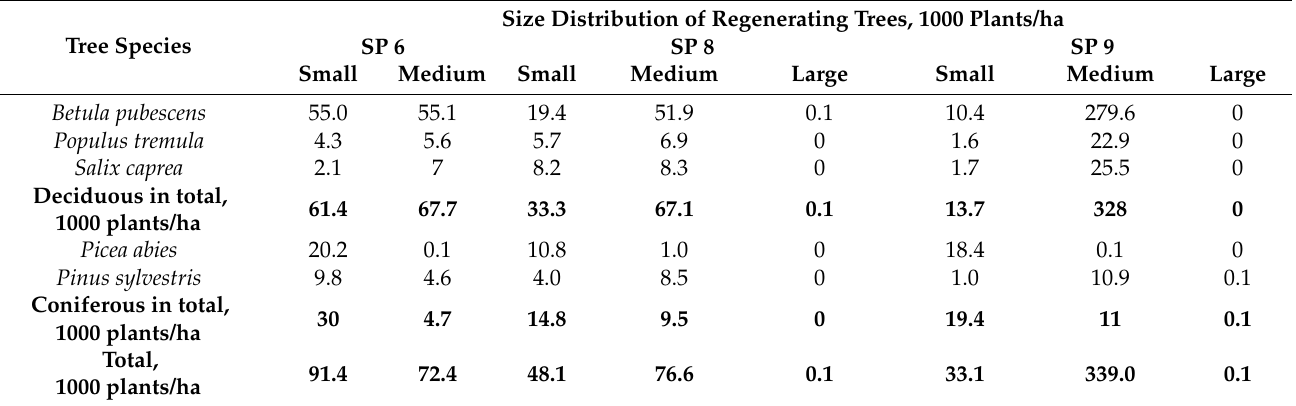
Table 3. Size distribution of the most common species of woody regeneration 10 years after surface fire. Size Distribution of Regenerating Trees, 1000 Plants/ha Tree Species SP 6 SP 8 SP